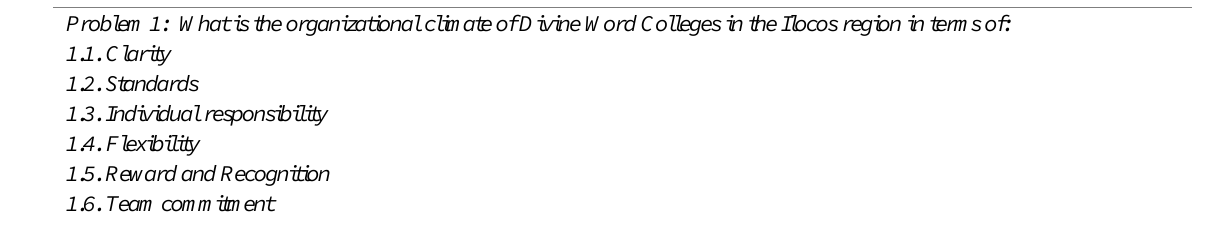
Table 1: Organizational Climate Along with Clarity